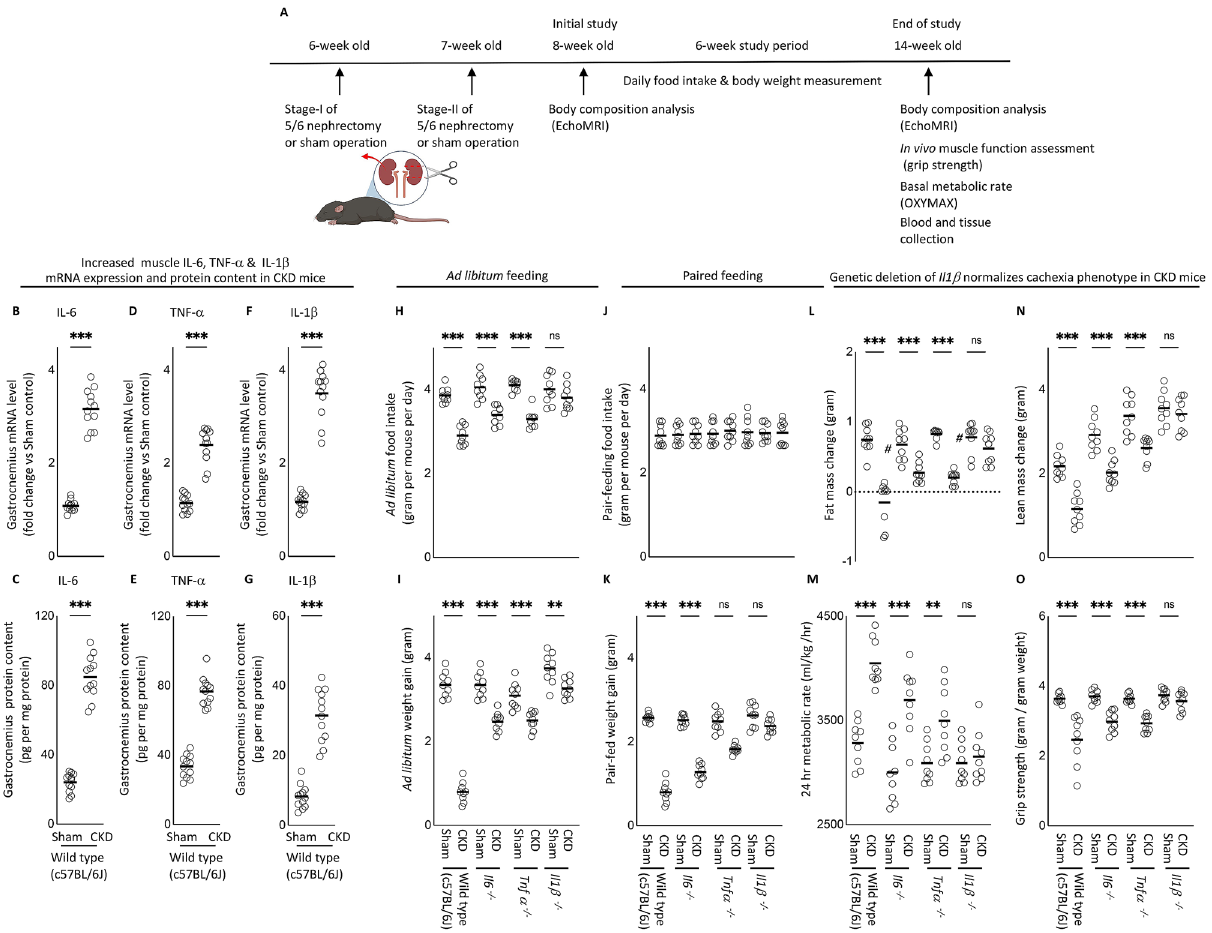
Figure 1. Increased muscle mRNA and protein content of IL-6, TNF-α and IL-1β in CKD mice and genetic depletion of Il1β provides a better rescue of cachexia in CKD mice compared to Il6 and Tnfα deficiency. Schematic experimental design is shown ( A ). ( A ) Was created with BioRender.com. Results of three experiments were shown. For the first experiment, CKD was induced by 5/6 nephrectomy in WT mice and sham operation was performed in WT control mice. Gene expression and protein content of pro-inflammatory cytokine IL-6, TNF-α and IL-1β in gastrocnemius muscle in WT/CKD and WT/Sham mice was performed. Data are expressed as mean ± SEM and results of WT/CKD mice were compared to WT/Sham mice ( B – G ). For the second experiment, four groups of mice were included: WT/CKD and WT/Sham, Il6 −/− / CKD and Il6 −/− / Sham, Tnfα −/− / CKD and Tnfα −/− / Sham, Ilβ −/− /CKD and Ilβ −/− /Sham. All mice were fed ad libitum and food intake as well as weight gain in mice were recorded ( H , I ). For the third experiment, we investigated the metabolic benefits of genetic depletion of Il6 , Tnfα and Il1β in CKD mice beyond the nutritional stimulation by employed a pair-feeding strategy. Four groups of mice are WT/CKD and WT/Sham, Il6 −/− / CKD and Il6 −/− / Sham, Tnfα −/− / CKD and Tnfα −/− / Sham, Ilβ −/− /CKD and Ilβ −/− /Sham. WT/CKD mice were fed ad libitum whereas other groups of mice were pair-fed to that of WT/CKD mice ( J ). Weight gain, fat and lean content, 24-h oxygen consumption and in vivo muscle function (grip strength) was measured in mice ( K – O ). For the second and third experiments, data are expressed as mean ± SEM and results of WT/CKD, Il6 −/− / CKD, Tnfα −/− / CKD and Il1β −/− /CKD mice were compared to WT/Sham, Il6 −/− / Sham, Tnfα −/− / Sham and Il1β −/− /Sham,